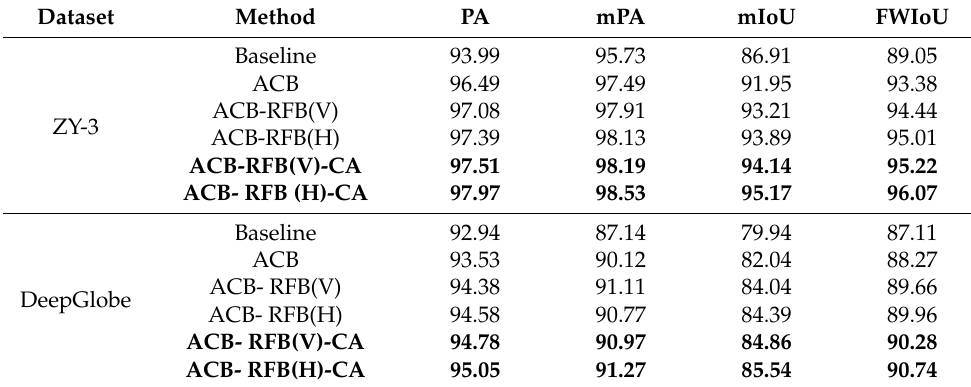
Table 4. Ablation results for the ACB, RFB and CA module